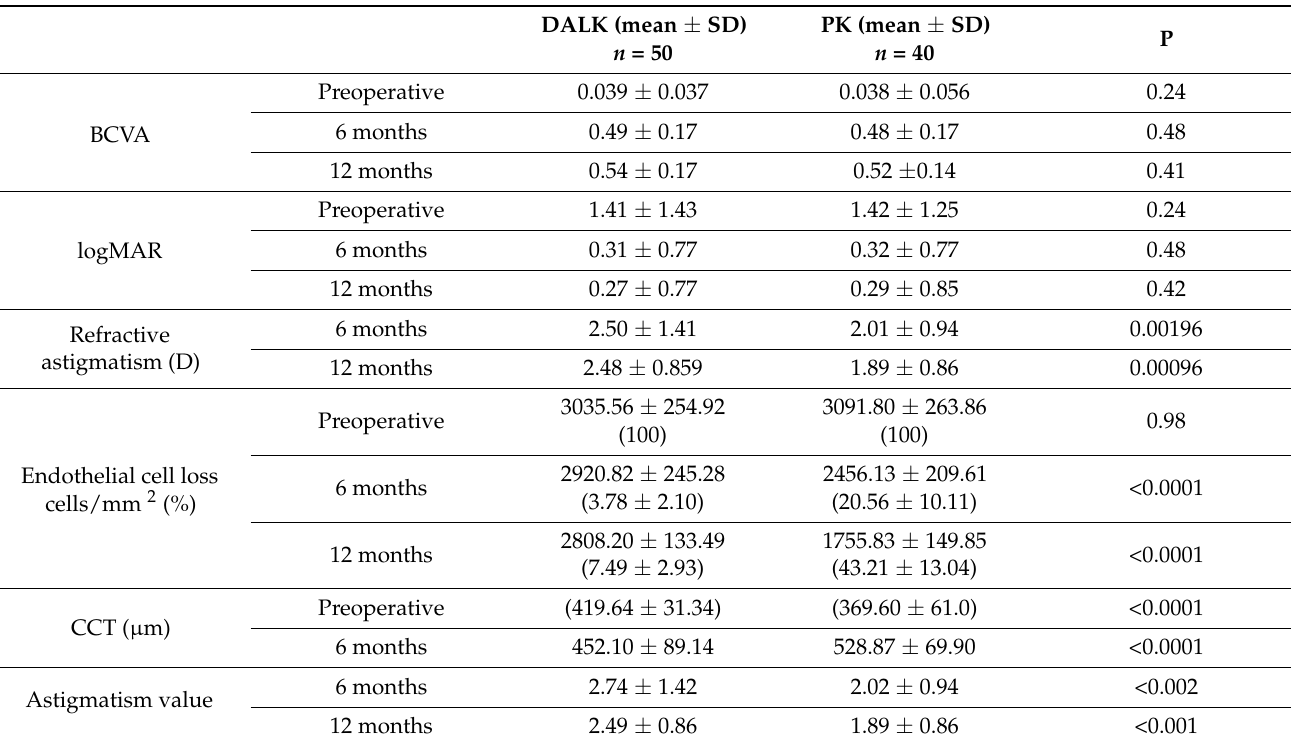
Table 3. Preoperative visual acuity and postoperative visual outcome and endothelial cell loss in the DALK and PK